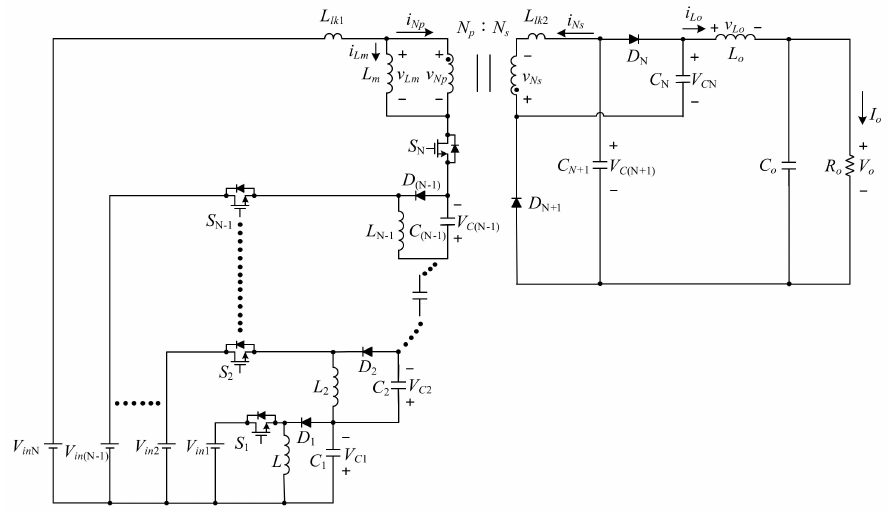
Figure 15. Expanded circuit.